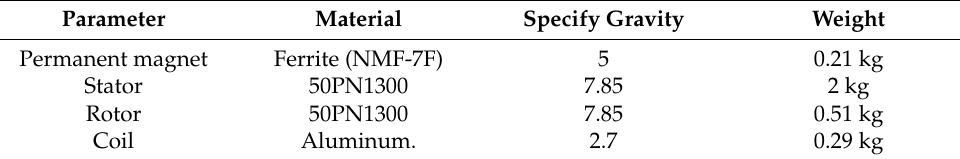
Table 1. Properties of each material.